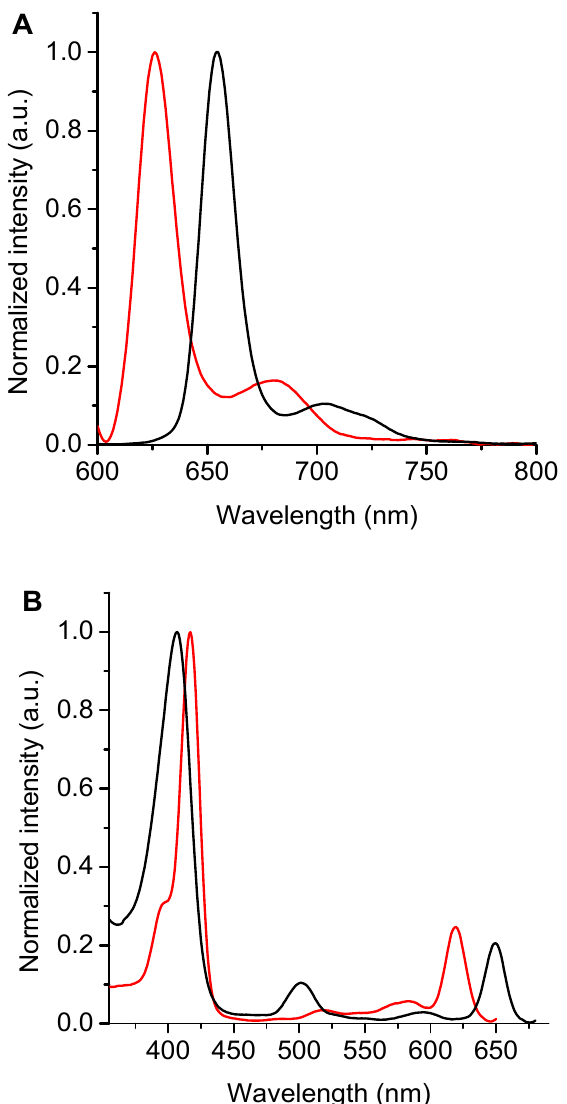
Figure 3. ( A ) Fluorescence emission spectra ( λ exc = 408 nm) and ( B ) fluorescence excitation spectra ( λ em = 700 nm) of TPCF 16 (black line) and ZnTPCF 16 (red line) in DMF. Table 1. Spectroscopic characteristics of TPCF 16 , ZnTPCF 16 , and PdTPCF 16 in